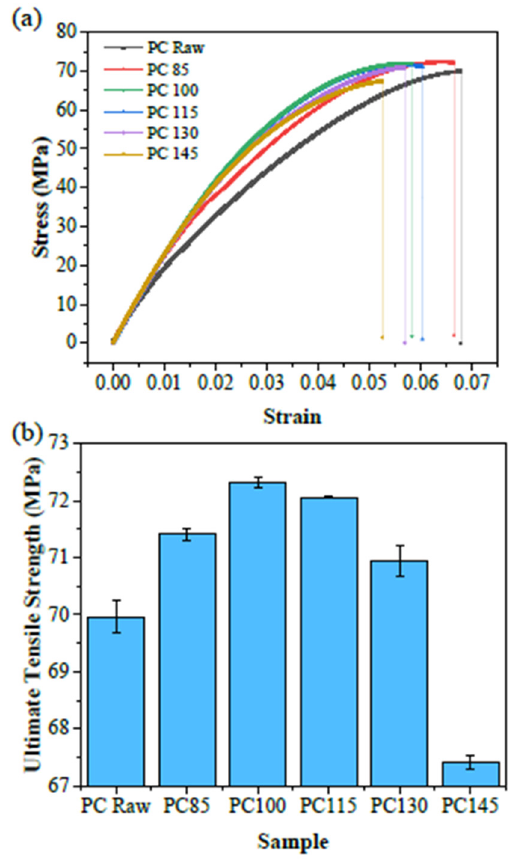
Figure 3. Tensile properties ( a ) The tensile stress-strain curves of the GF-PC composites before and after aging; ( b ) The ultimate tensile strength of the GF-PC composites before and after aging.